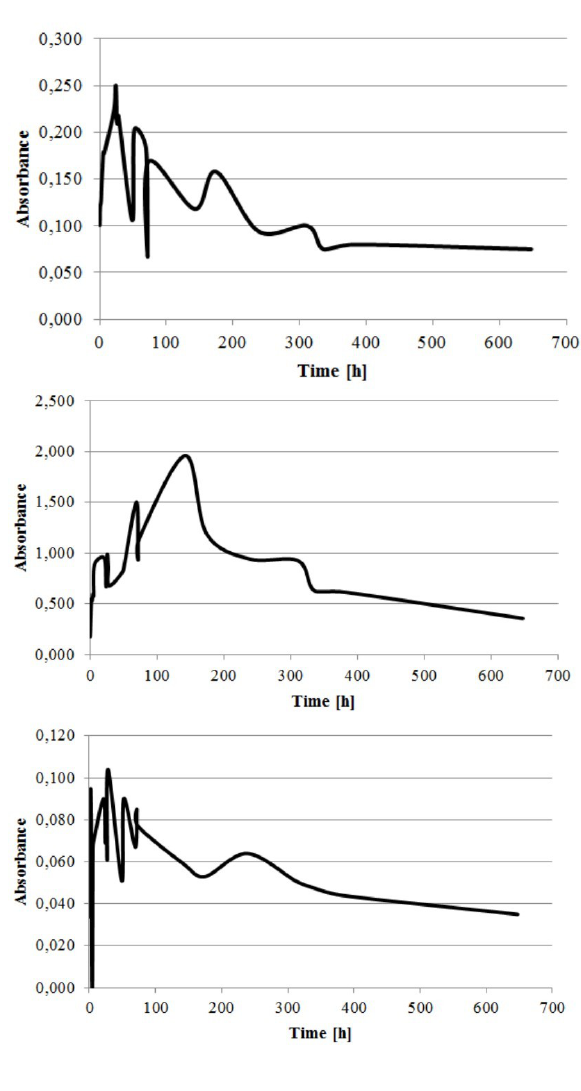
Figure 8. Growth curves of bacteria in 253 media (on top), in 253 media with 2% CaCl middle) and in the water (on